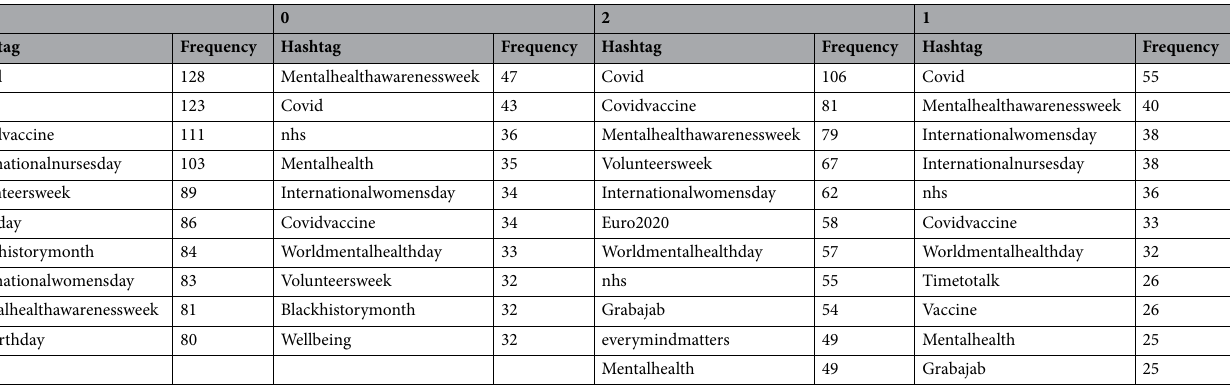
Table 8. Frequency of top 10 hashtags in the subcommunities with more than 50 nodes in Orchid